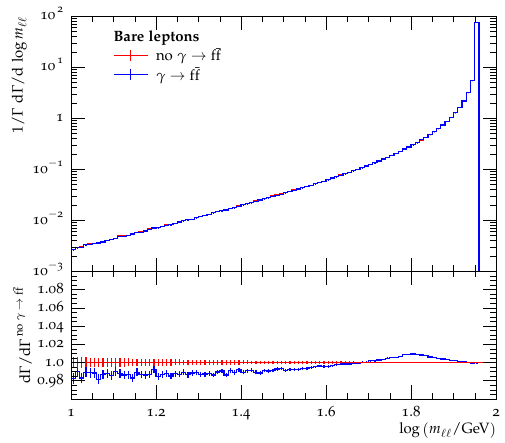
Figure 8 . The bare dilepton invariant mass m ‘‘ as described by the YFS soft-photon resummation only (red) or additionally resolving the photons further into pairs of charged particles (blue), in the mixed ordering